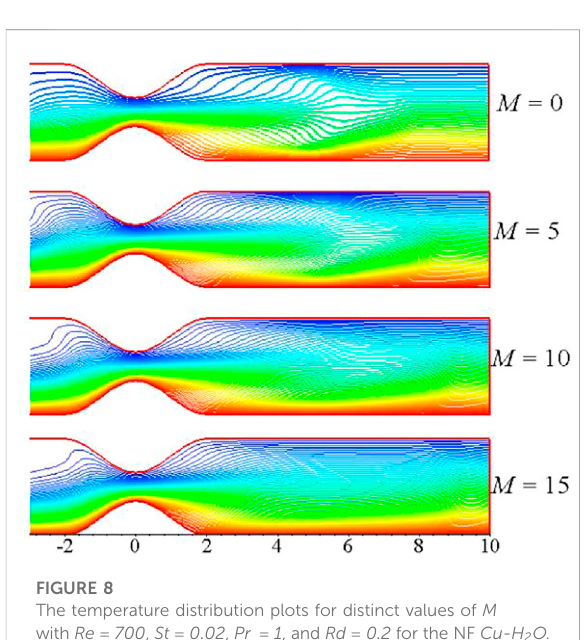
The temperature distribution plots for distinct values of M with Re (cid:2) 700 , St (cid:2) 0 . 02 , Pr (cid:2) 1 , and Rd (cid:2) 0 . 2 for the NF Cu - H 2 O .